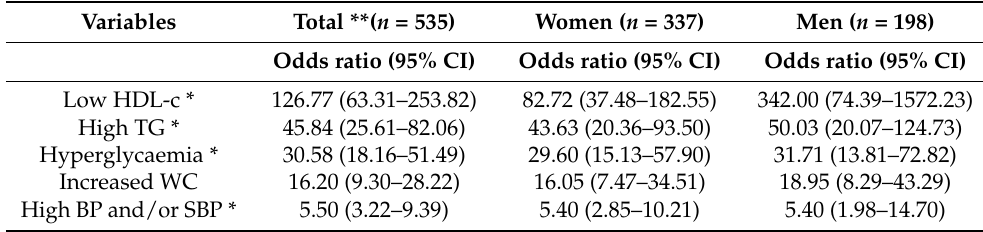
Table 2. Odds ratios with 95% confidence interval for the association between the risk of metabolic syndrome and its components.